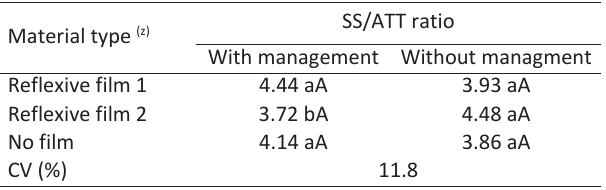
* Means followed by the same lowercase letter in the column don’t differ significantly by the level of 5% by Tukey’s test. (Z) Reflexive polypropylene white raffia plastic (Reflexive film